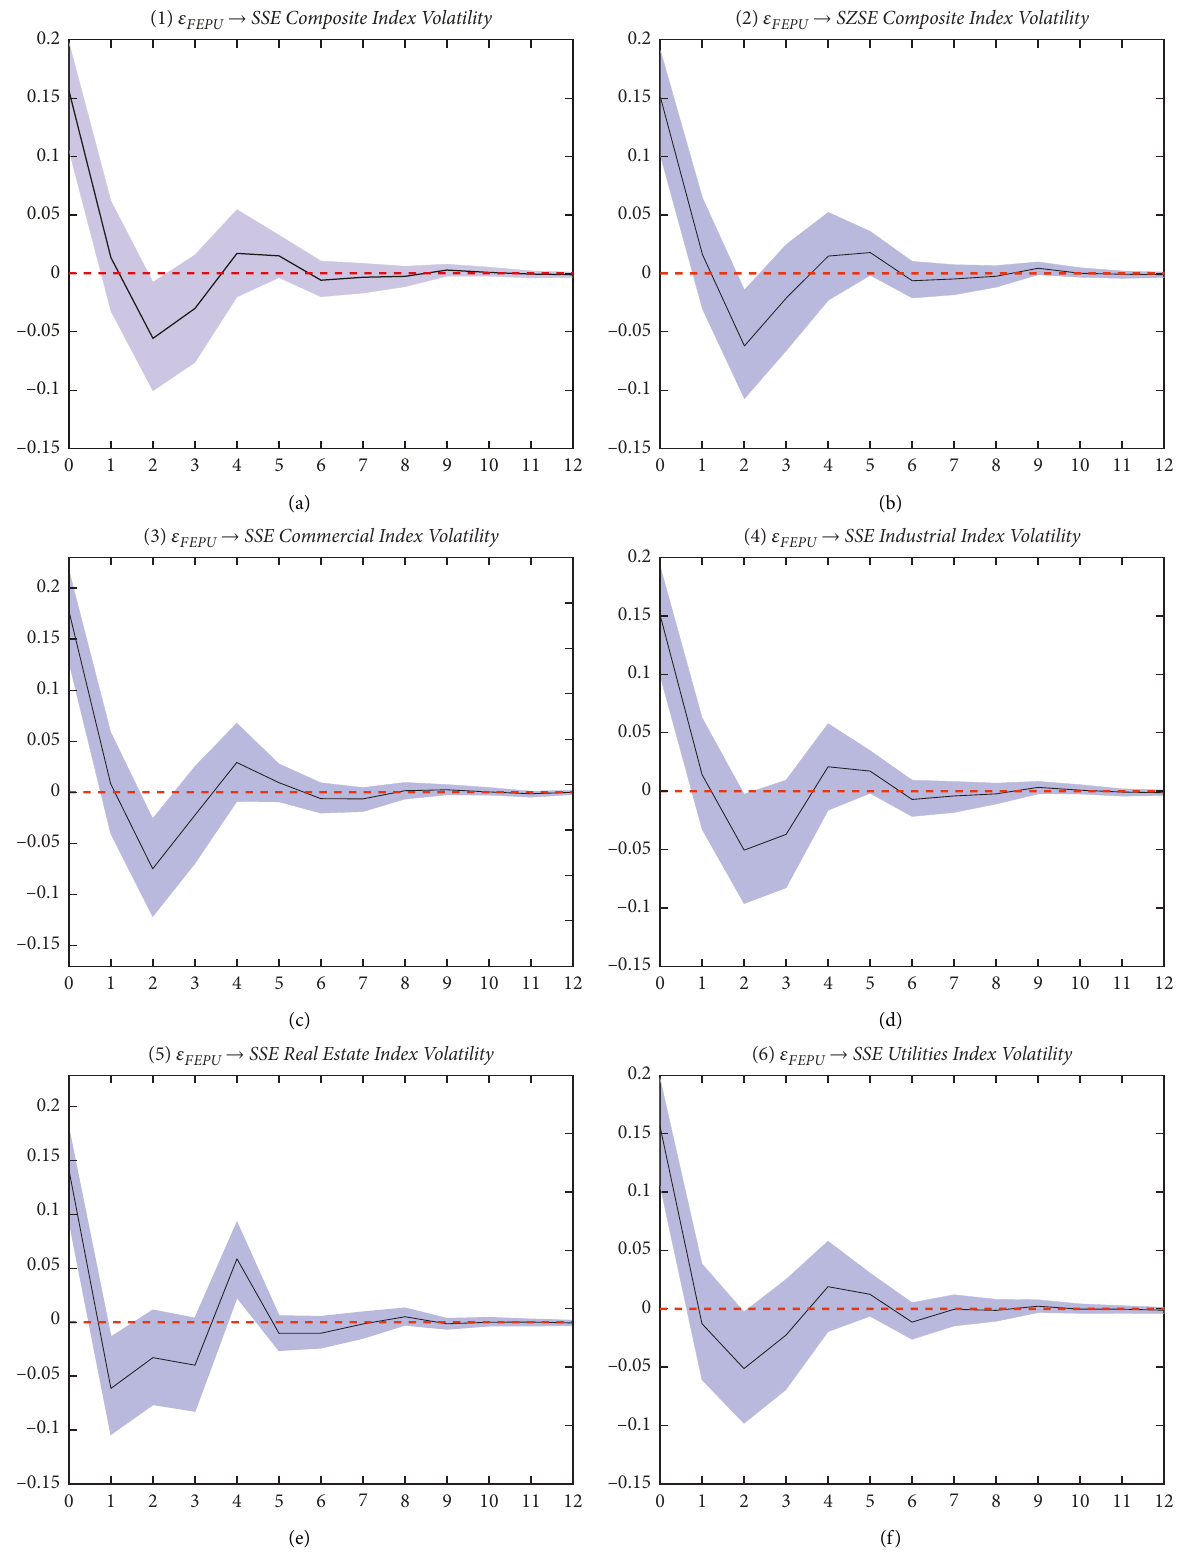
Figure 9: Impulse response of stock market volatility to fiscal EPU (FEPU) shocks. Notes: the solid black lines denote the median impulse response. The light-colored region represents 68% of error bands. Each period is a